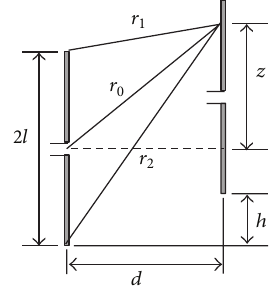
Figure 8: Two parallel dipoles.